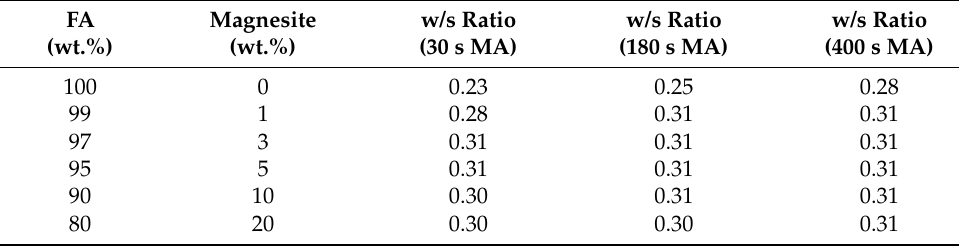
Table 2. Composition of mixtures used for preparation of